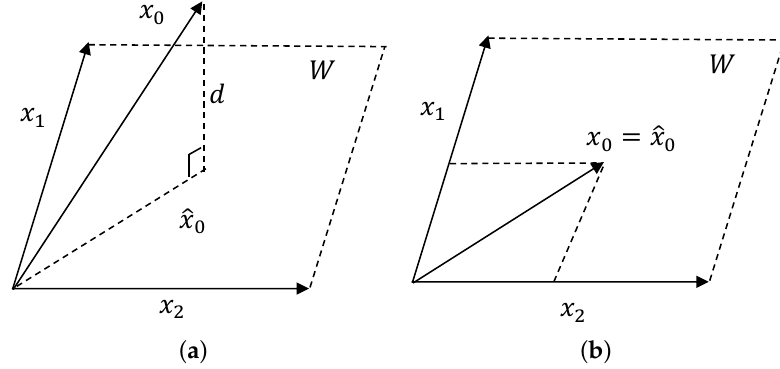
Figure 1. An intuitive explanation of orthogonal projection. ( a ) The vector x 0 cannot be linearly represented by the vectors x 1 and x 2 . ( b ) The vector x 0 can be linearly represented by the vectors x 1 and x 2